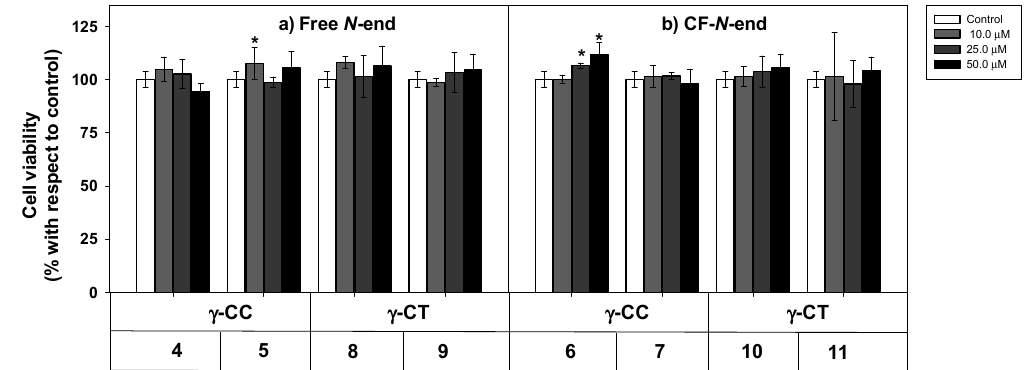
Figure 2. Cytotoxicity of peptides 4 – 11 on HeLa cells. Peptides with ( a ) terminal free amino group; ( b ) terminal amino group conjugated with CF. Cells were incubated with the respective peptide for 24 h and their viability assayed by 3-(4,5-dimethylthiazol-2-yl)-2,5-diphenyltetrazolium bromide (MTT) reduction. Cell viability was expressed as the percentage of MTT reduction with respect to control cells ± SD. Statistical significance with respect to control cells: p ≤ 0.05 (*). Samples were made in quadruplicate, and experiments were repeated thrice independently.